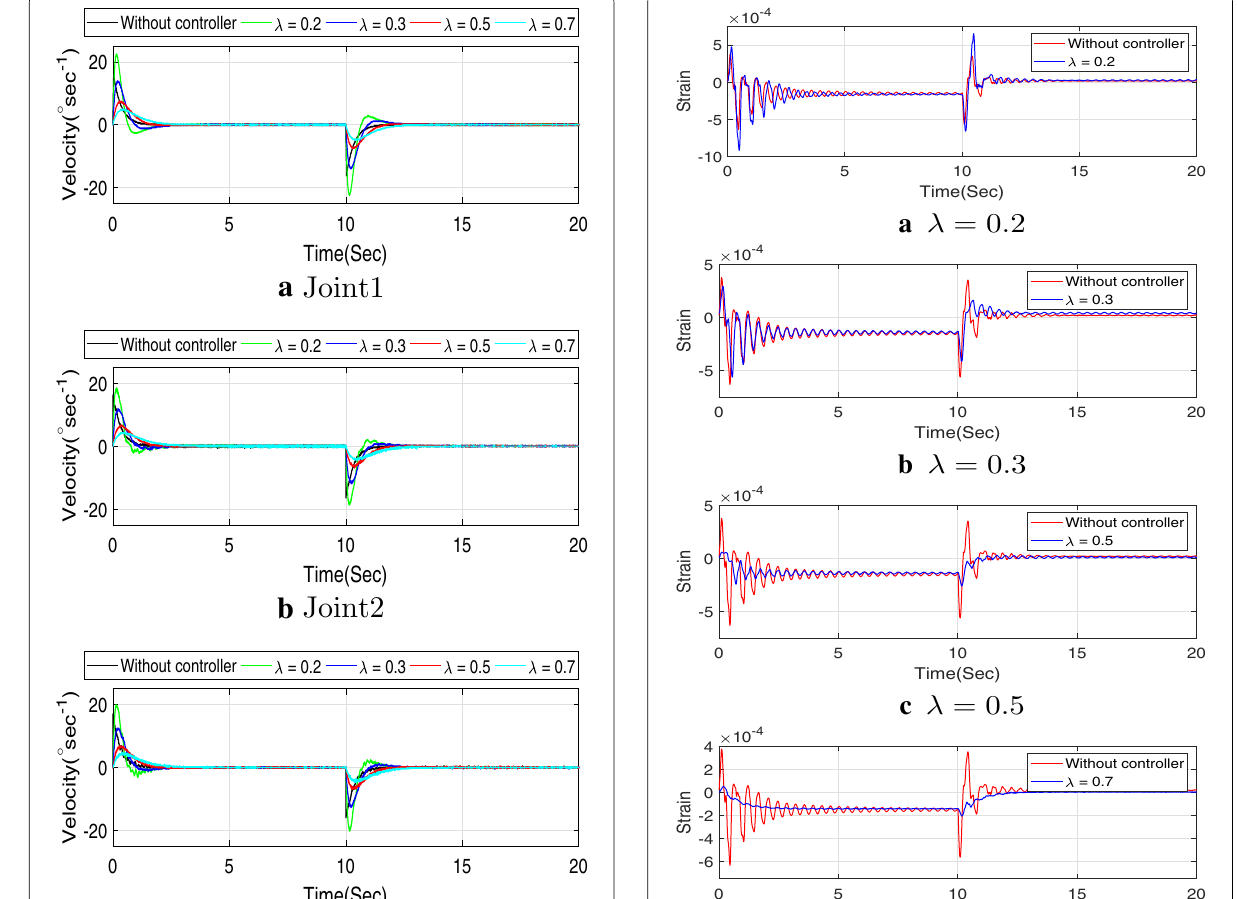
Fig. 12 Link 1 in-plane strain for varying